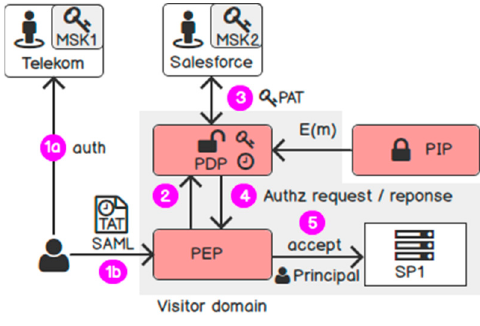
Figure 13. Request flow.